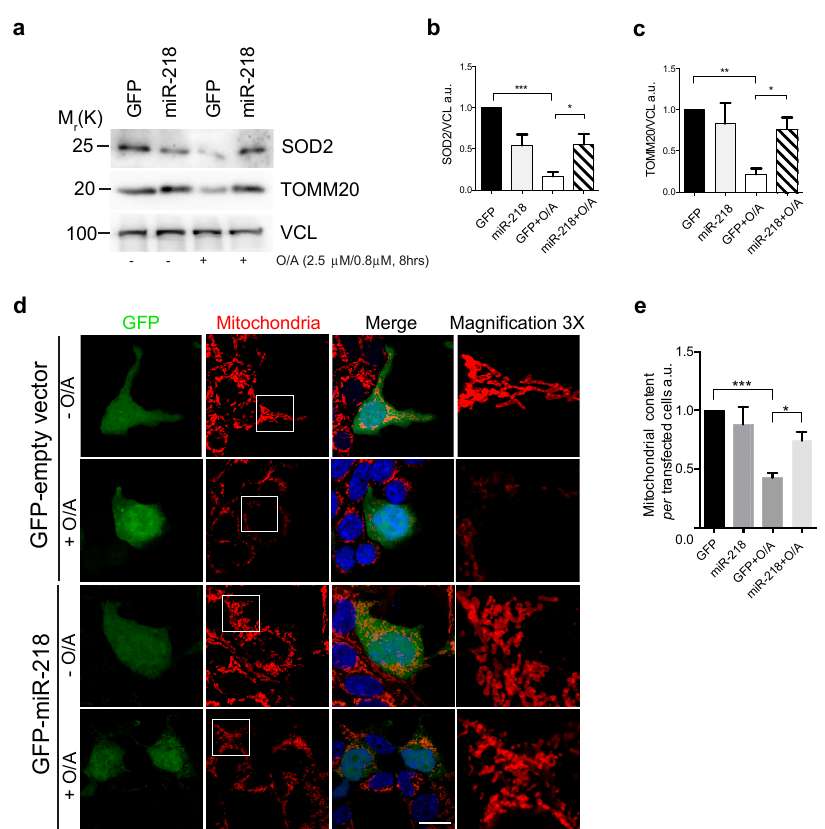
Figure 2. ( a ) HEK293 cells transfected with GFP or GFP-miR-218 vectors and then treated with O/A (Oligomycin and Antimycin A 2.5 μ M, 0.8 μ M, 8 h) were immunoblotted for the indicated antibodies. ( b , c ) The graphs show the SOD2 (superoxide dismutase 2) and TOMM20 (translocase of outer mitochondria membrane 20) protein level normalized on the VCL (Vinculin) loading control. ( d , e ) Representative immunofluorescence image and related graph in which GFP or GFP-miR-218 overexpressing HEK293 cells were immunostained with an anti-TOMM20 to detect mitochondria (red). Magnifications (3X) of the areas localized in the white frames are illustrated for each immunofluorescence. Scale bar, 10 μ m. All data represent the mean of experimental triplicate (±s.e.m.). Statistical analysis was performed using One-Way ANOVA with Sidak’s correction. * p < 0.05; ** p < 0.01; *** p < 0.001. Mr(K) = relative molecular mass expressed in Kilo Dalton.